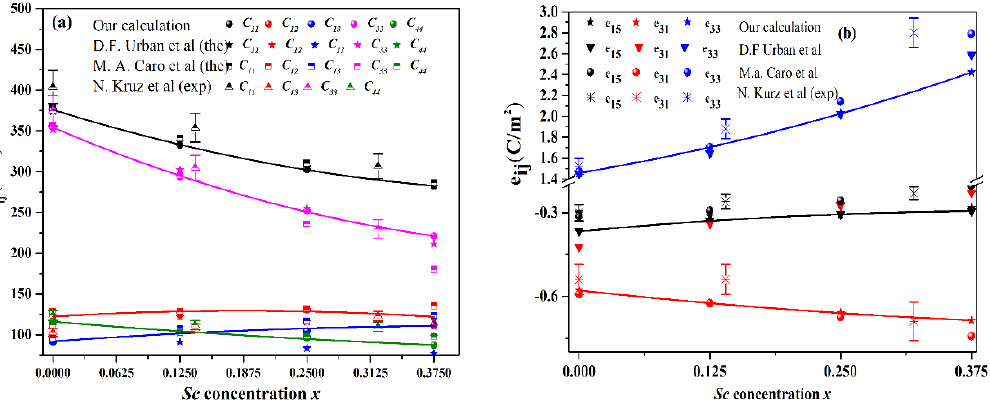
Figure 2. Comparison between ( a ) our calculated elastic constants C ij (GPa), and ( b ) piezoelectric coefficients eij (C/m 2 ), with data available from the literature .